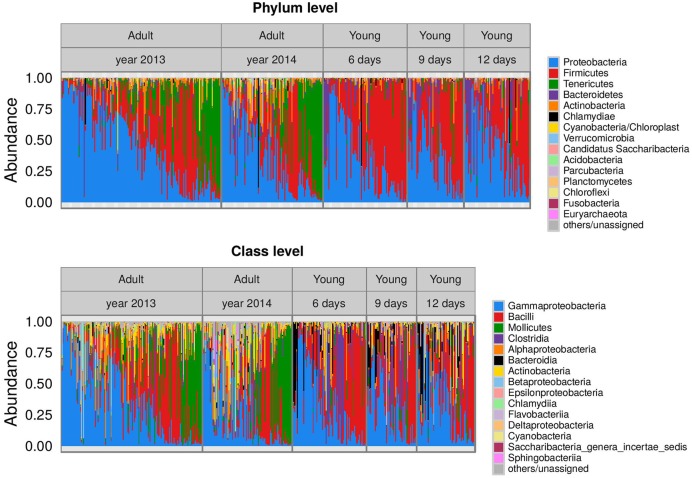
Barplots indicating barn swallow fecal microbiota (FM) taxonomic composition. Mean proportion of reads for the 15 dominant bacterial phyla and classes detected in juvenile and adult barn swallow samples. Samples are organized according to age category (in the case of juveniles) and year of sampling (in the case of adults). Sample order within facetes correspond to scores for the first principal coordinate analysis (PCoA) axis calculated based on weighted UniFrac.